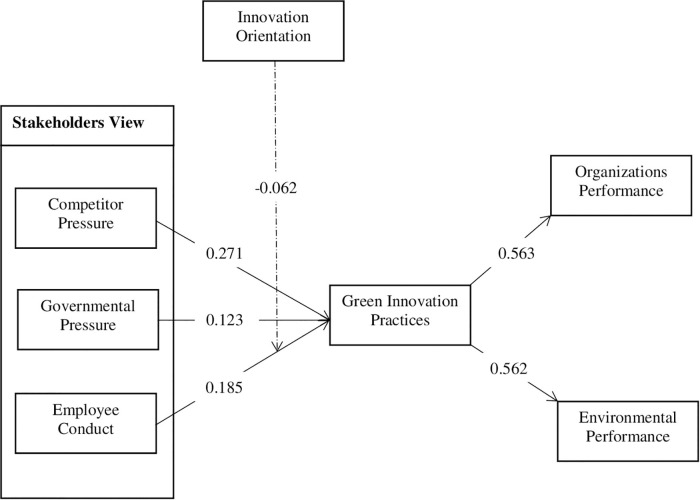
Structural model of the study.